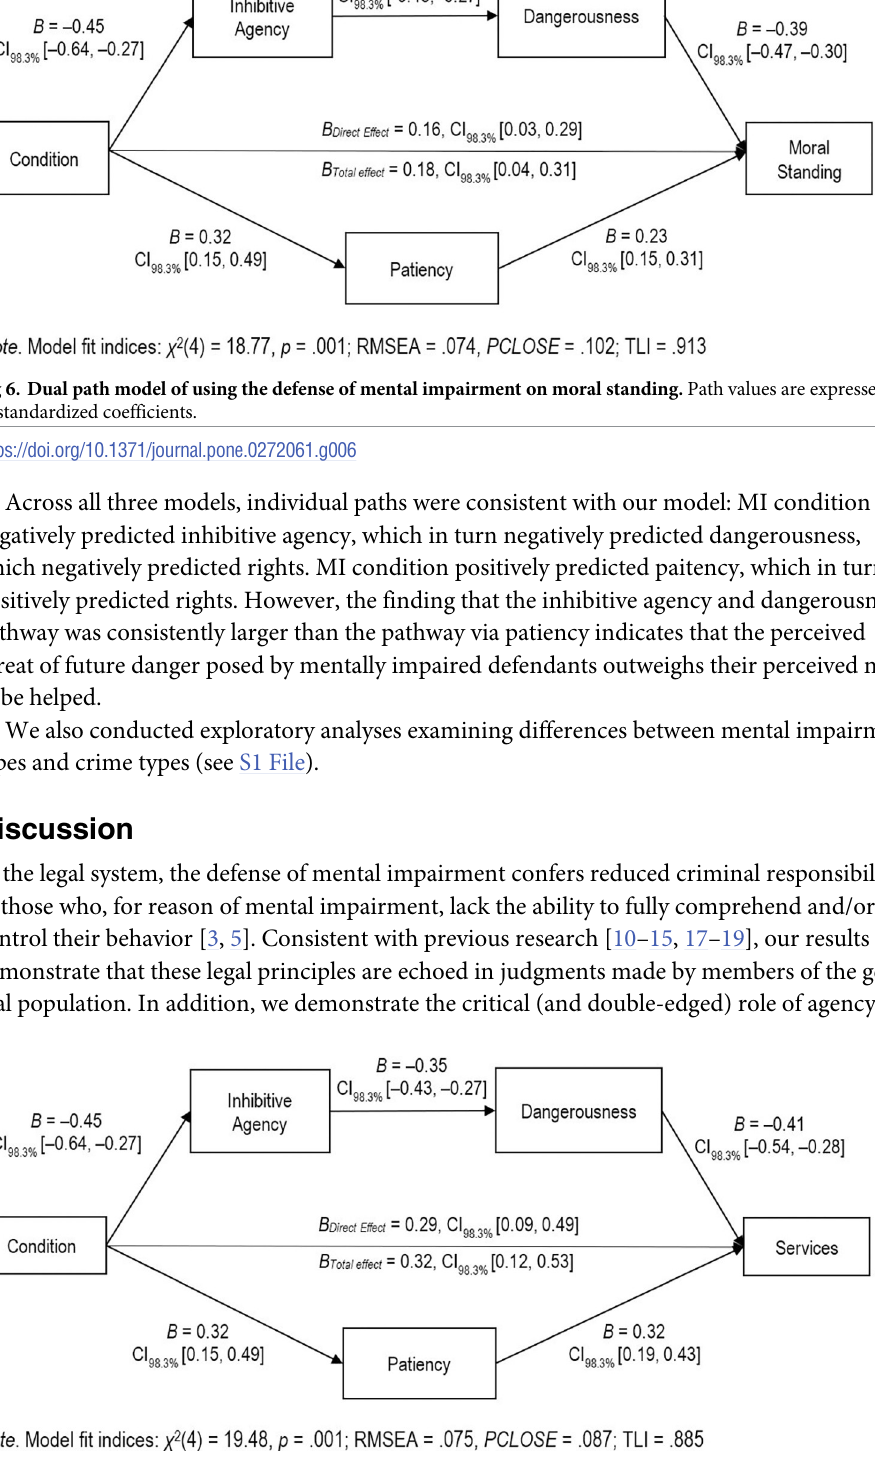
Fig 7. Dual path model of using the defense of mental impairment on access to services. Path values are expressed in unstandardized coefficients.